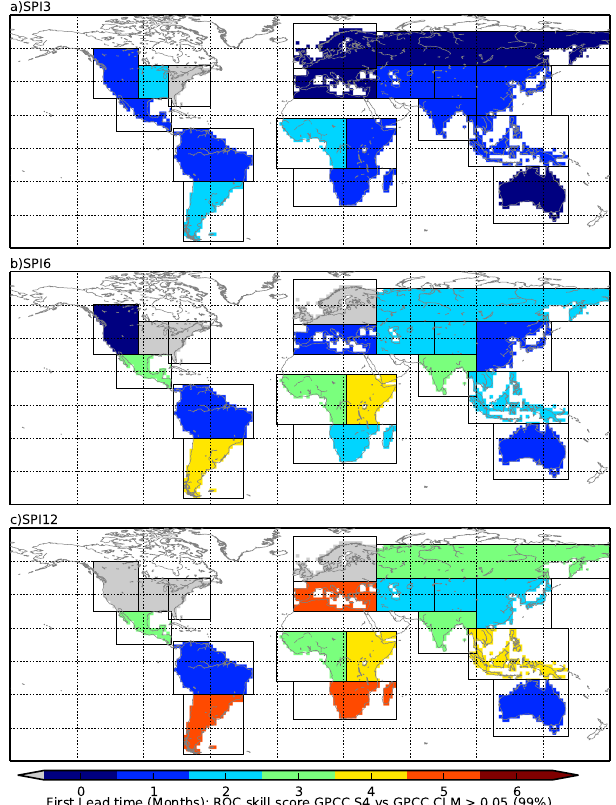
Figure 4. First forecast lead time (months) where the ROC skill score of GPCC S4 (using GPCC CLM as reference forecasts) is higher than 0.05 with 95% confidence and the ROC of GPCC S4 is higher than 0 with 95% confidence. Seasonal forecasts of the (a) SPI-3, (b) SPI-6, and (c) SPI-12. The forecasts are verified in each region for the calendar month presented in Table 1.